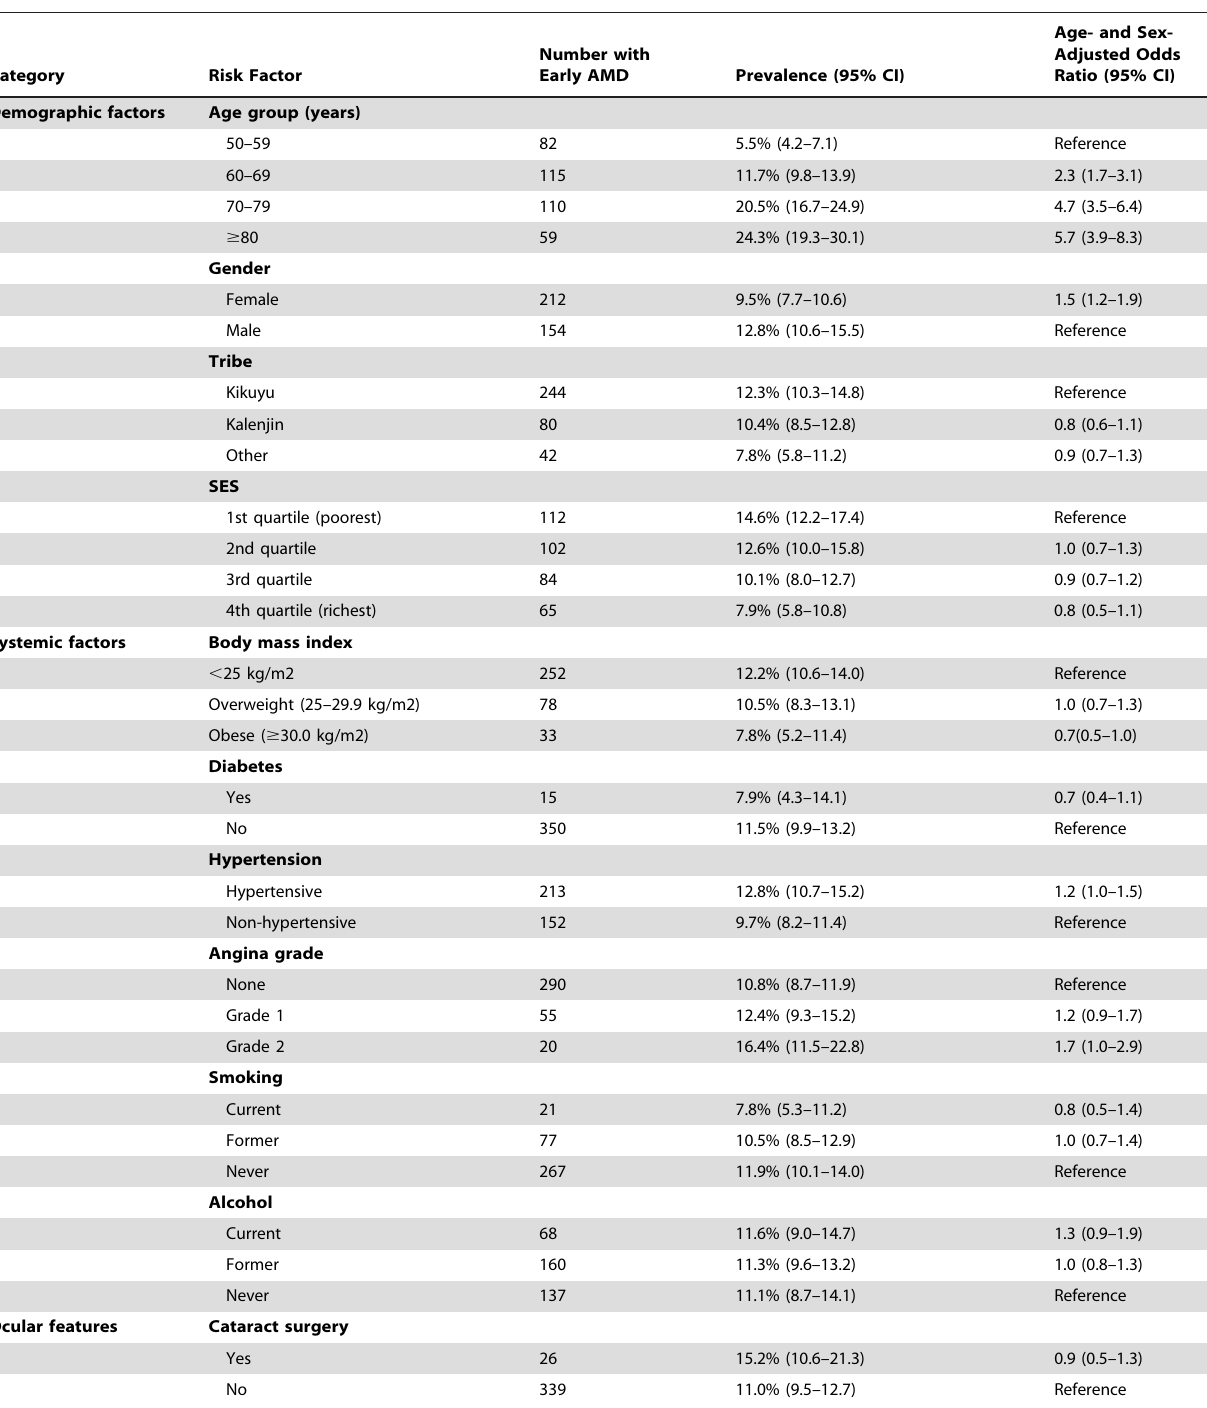
Table 6. Risk factors for early